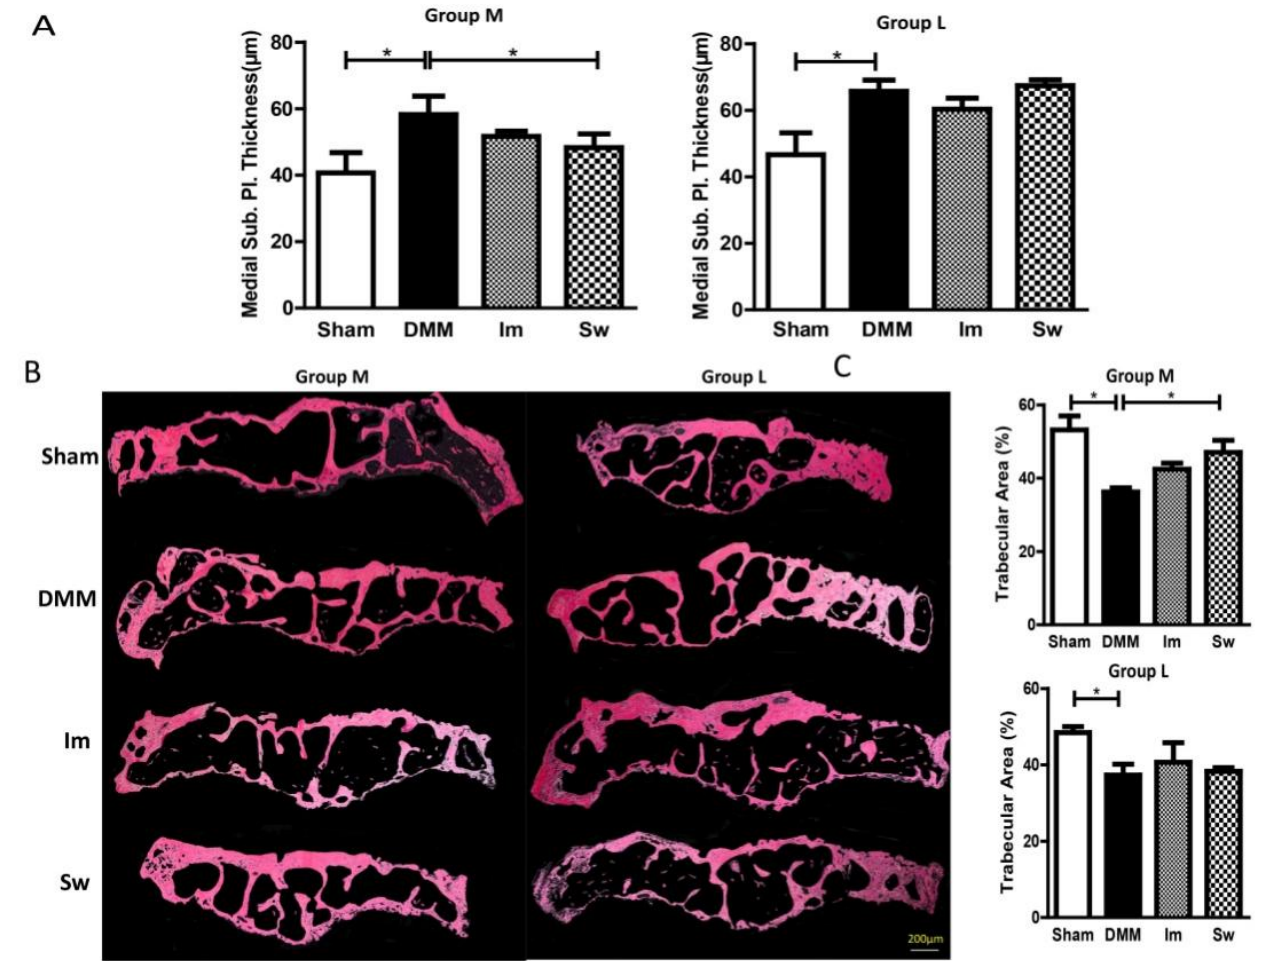
Figure 6. Swimming partly relieved the increase in thickness and the decrease in trabecular area in subchondral bone in Group M. ( B ) The morphology of subchondral bone. ( A ) DMM significantly increased the thickness and ( C ) decreased the area of subchondral bone in both Groups M and L. Swimming partly attenuated the alteration caused by DMM in Group M. Group M: middle stage of OA, 4 weeks after DMM and Group L: late stage of OA, 8 weeks after DMM. Im, immobilization; Sw, swim; DMM, destabilization of the medial meniscus; * p < 0.05, n ≥ 6; bar = 200 µ m. Moreover, the cross-sectional area of bone trabecula at the tibial metaphysis was smaller in DMM mice than in Sham mice in both Groups M and L. In Group M, swimming rescued the decrease in area, whereas immobilization did not. In addition, no obvious difference was found among the three subgroups in Group L (Figure